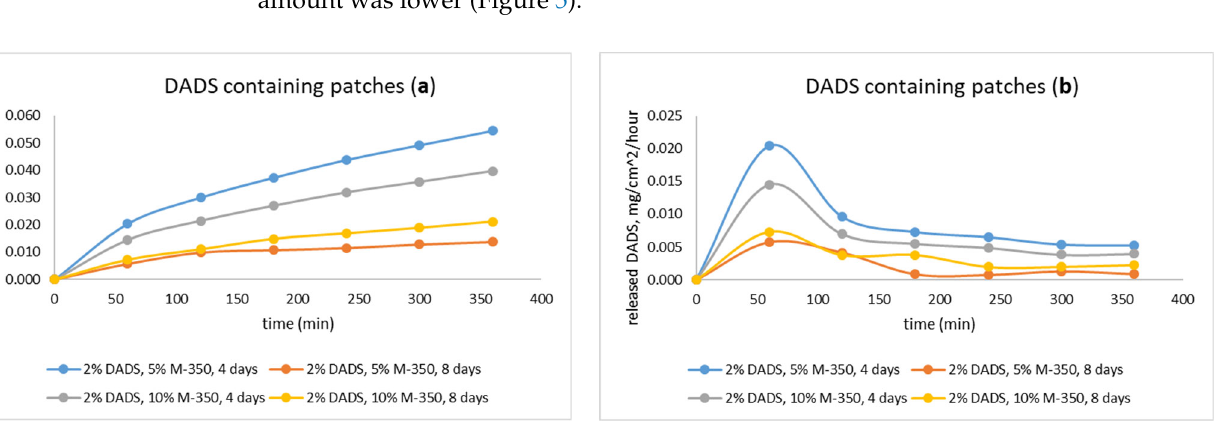
Figure 5. The cumulative ( a ) and continuous ( b ) release rate of the samples in the flow ‐ through